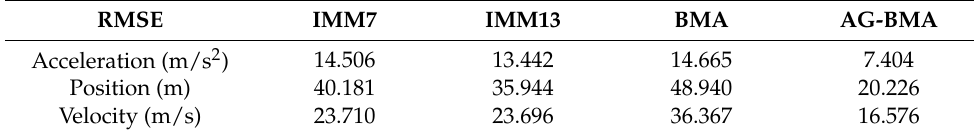
Table 4. Average root-mean-square error corresponding to the four algorithms. RMSE IMM7 Acceleration (m/s 2 )